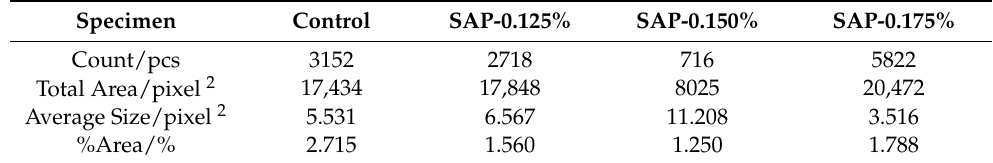
Table 9. Statistical summary diagram of pores with different dosage in 75 cycles. Specimen